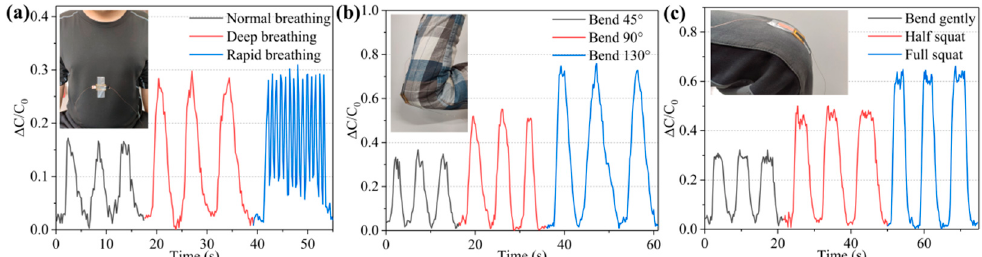
Figure 12. Human body signals acquired by the sensor. ( a ) Different breathing states. ( b ) Different degrees of elbow joint bending. ( c ) Different degrees of knee joint bending.